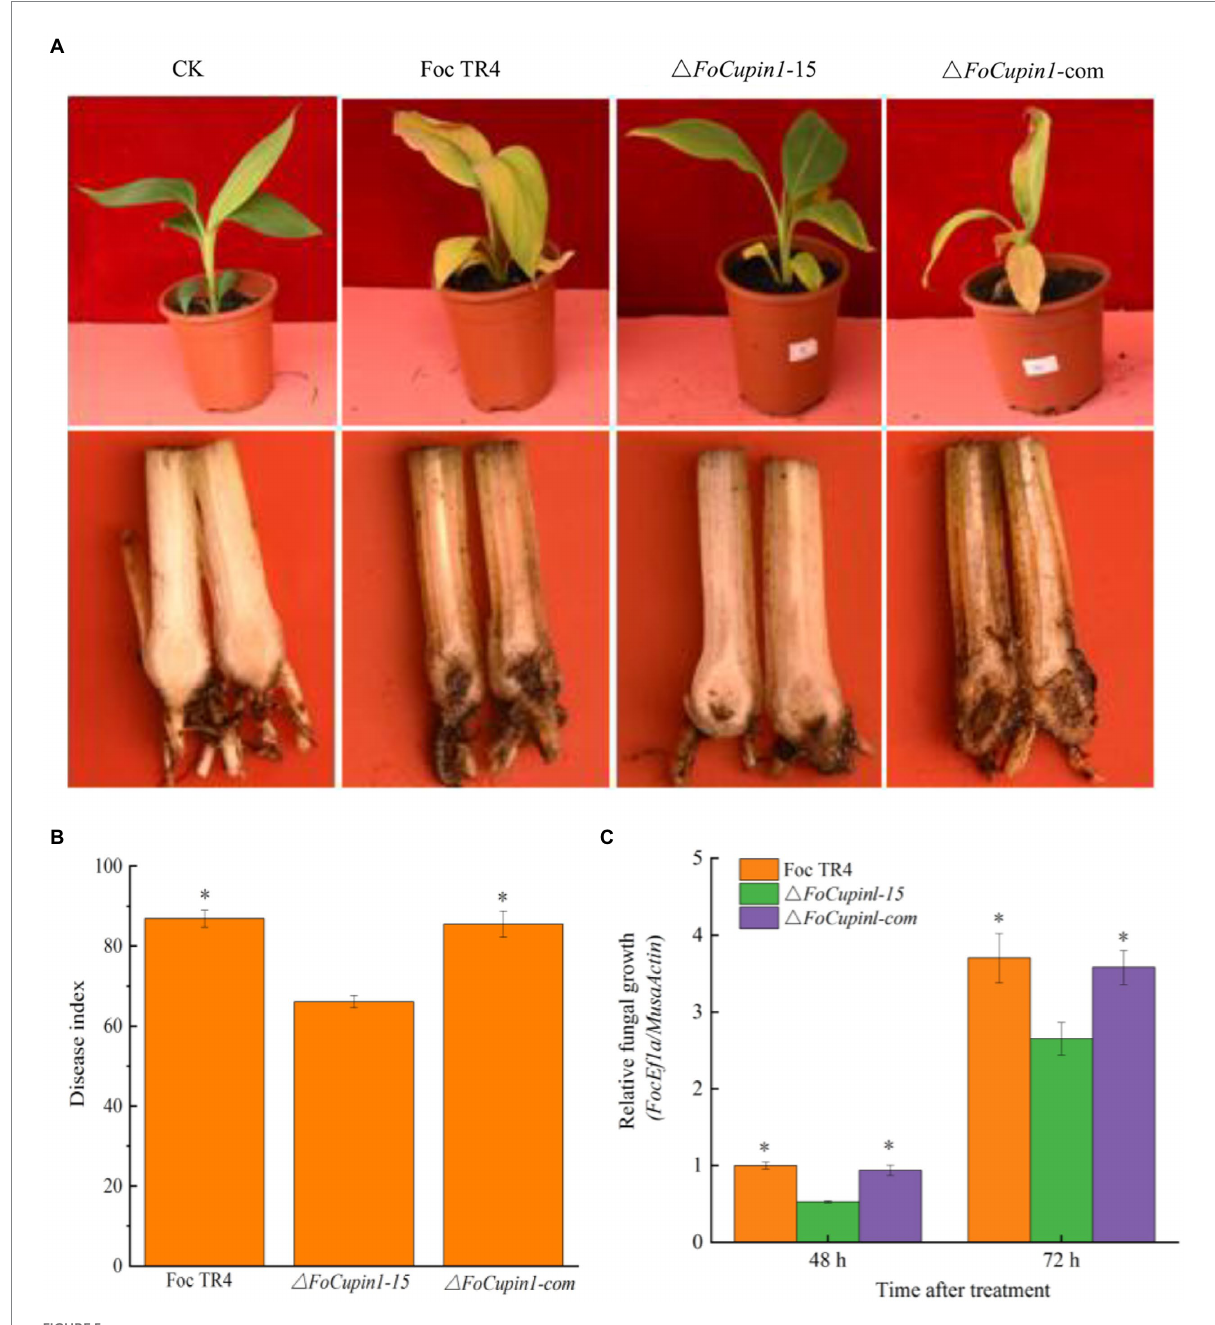
FIGURE 5 Pathogenicity assay of FoCupin1 deletion mutant and complementation strain. (A) Disease phenotype. Banana plantlets at fully fourth-leaf stage were inoculated with FoCupin1 deletion mutant and complementation strain. The plantlets were photographed 28 days post-inoculation. (B) Disease index. (C) Relative biomass assay. The relative fungal growth was measured by [2 [CT( MaActin )-CT( FoEF1a )] × 100] using qPCR. Values are the means (±SE) based on three independent experiments and bars indicate standard deviations. Asterisks indicate statistical significance ( p < 0.05) using Student’s t